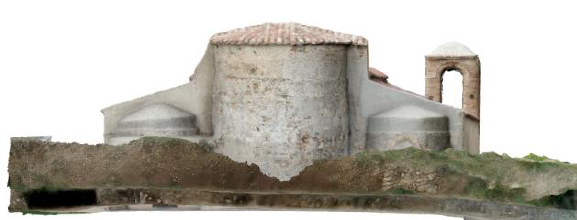
Figure 3. South view of the reconstructed 3D Model – outside